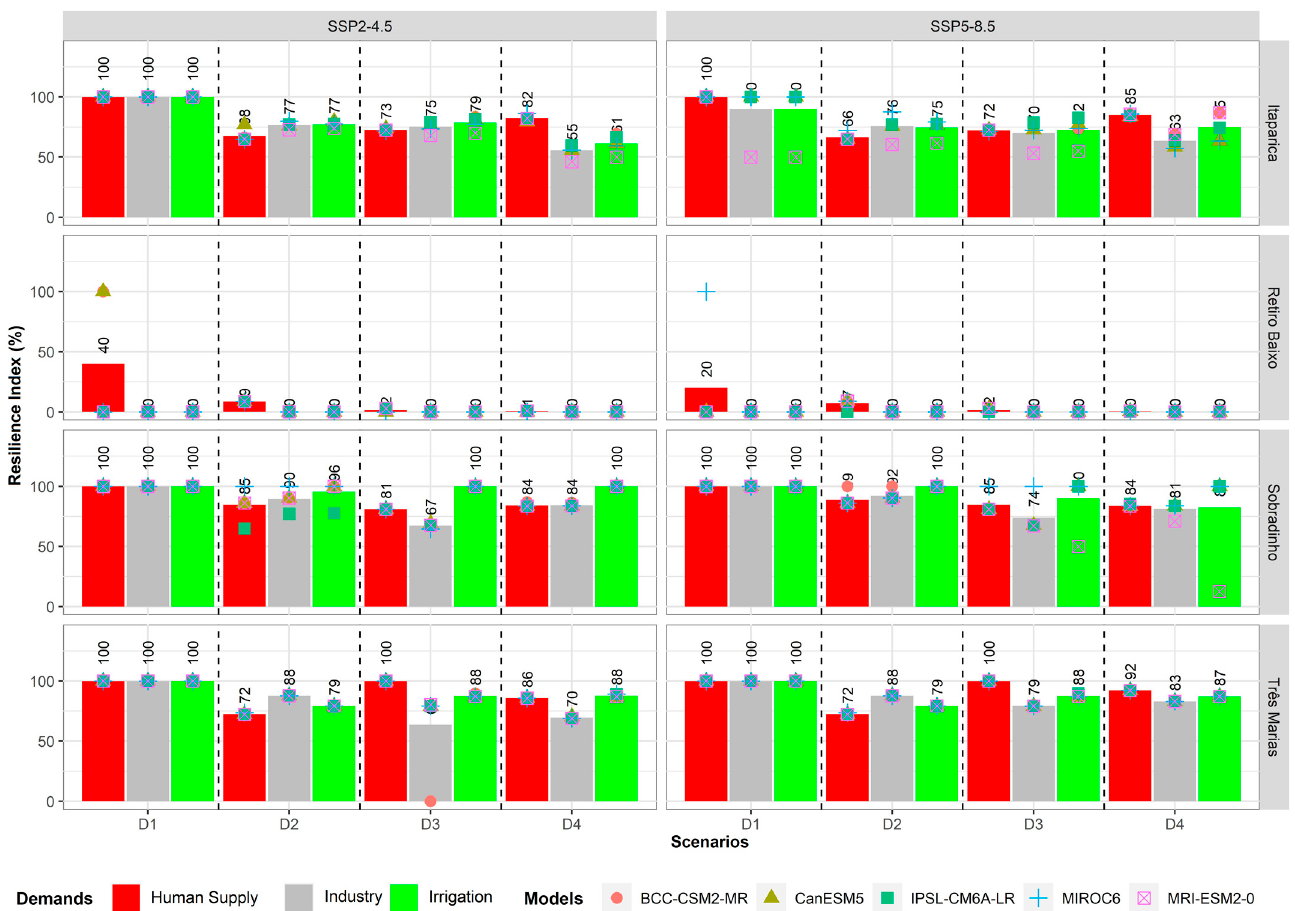
Figure 10. Resilience Index of CMIP6 models for historical period (1971 to 2000), climate change scenarios (SSP2-4.5 and SSP5-8.5) and consumptive demands projection scenarios (D1, D2, D3 and D4) for SFRB reservoirs. The bars are the averages of the set of models.